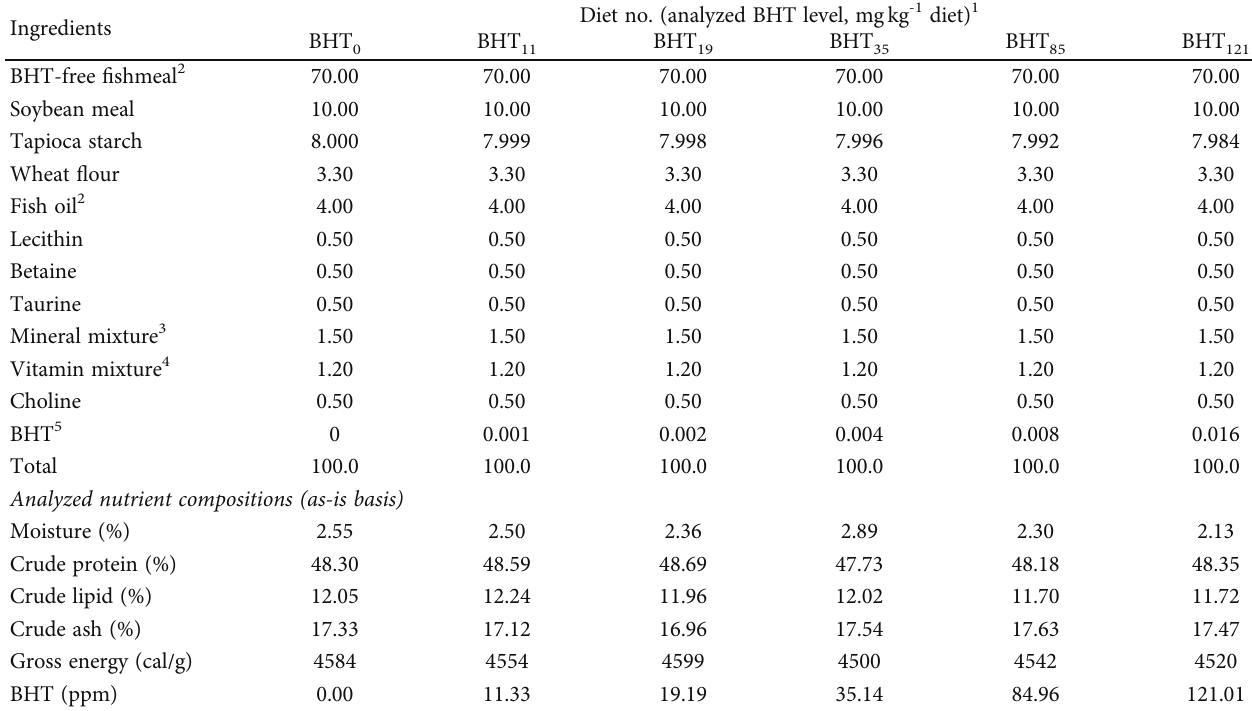
Table 1: Ingredient composition of the experimental diets (gkg -1 of as-is